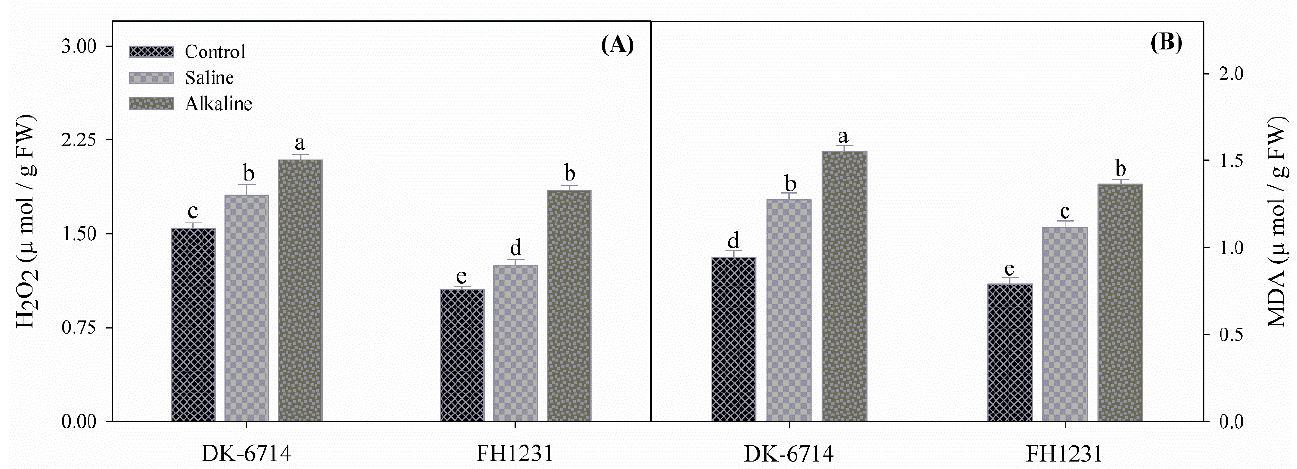
Figure 5. Effect of salinity and alkalinity stress on ( A ) hydrogen peroxide (H 2 O 2 ) and ( B ) malondialdehyde (MDA) content in 20-day-old maize seedlings of two hybrids (DK-6714 and FH-1231). The bars represent the standard error (SE) of the four replicates. Similar small letters above bars represent nonsignificant (ns) differences among treatments ( p ≤ 0.05).